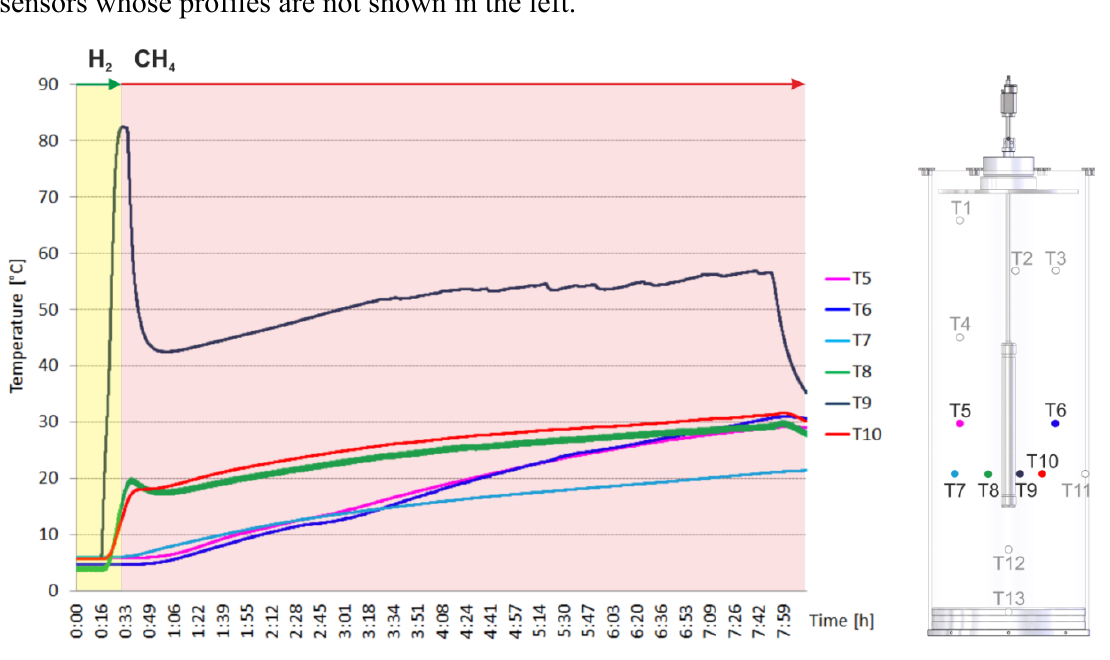
Figure 5. Left: Temperature profiles versus time for production experiments using the reactor in sediment + water + hydrate (40%) with external cooling (4 °C). Right: Positions of the temperature sensors within LARS, empty circles show positions of temperature sensors whose profiles are not shown in the left.